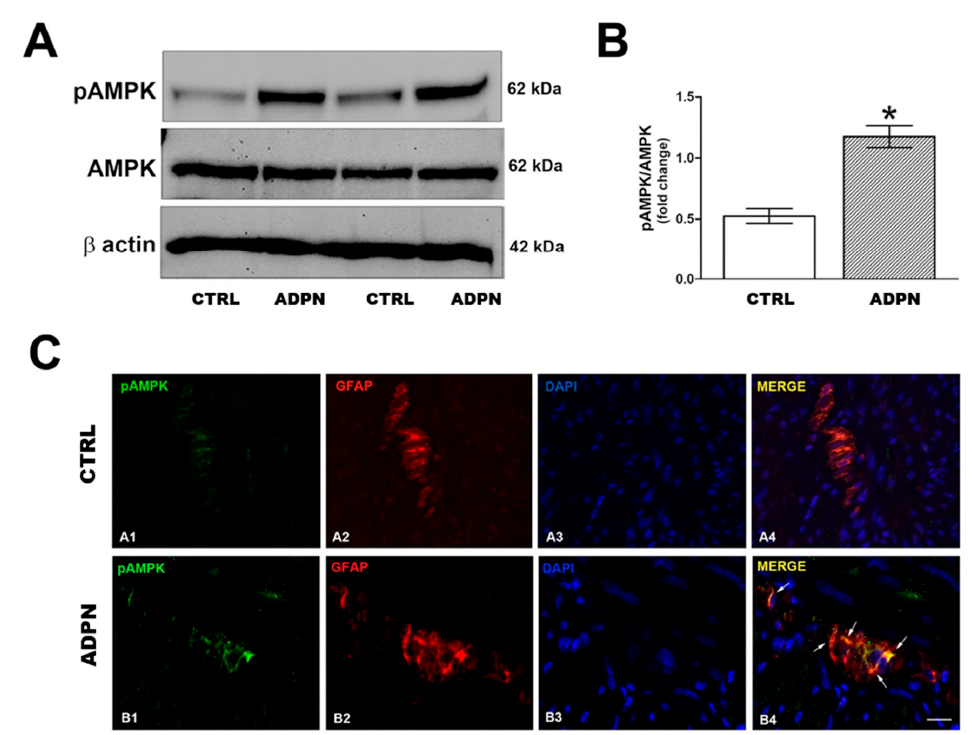
Figure 7. Involvement of AMPK signaling in ADPN action. ( A ) Effect of ADPN on AMPK signaling pathway in mouse gastric fundus assayed by Western blotting: representative bands from a typical experiment. ( B ) quantitative analysis. Columns are means ± SEM. Significance of differences (Student’s t -test for two independent samples): * p < 0.05 vs. controls (CTRL). ( C ) Representative photomicrographs of gastric tissue from control and ADPN-treated mice showing double immunofluorescence labeling. ( A1–A4 ) co-localization of phosphoAMPK (pAMPK) and GFAP in control mice: ( A1 ) pAMPK signal (green channel); ( A2 ) GFAP signal (red channel); ( A3 ) DAPI; ( A4 ) merged images. ( B1–B4 ) co-localization of pAMPK and GFAP in ADPN-treated mice: B1 pAMPK signal (green channel); ( B2 ) GFAP signal (red channel); ( B3 ) DAPI; ( B4 ) merged images. Scale bar: 10 μ m.